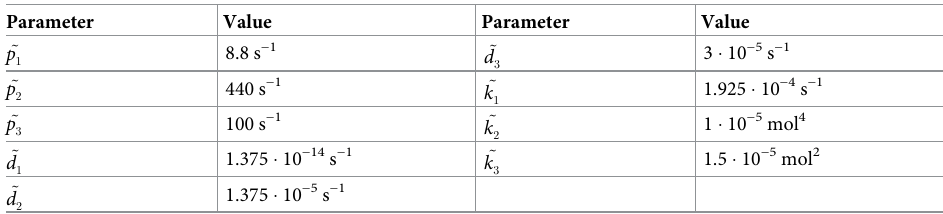
Table 1. Parameters value for the nonlinear model.